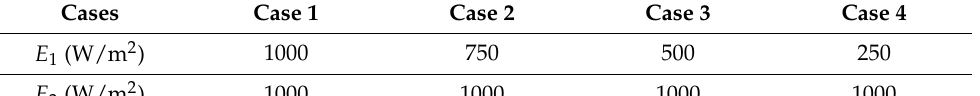
Table 2. Mismatch Cases.